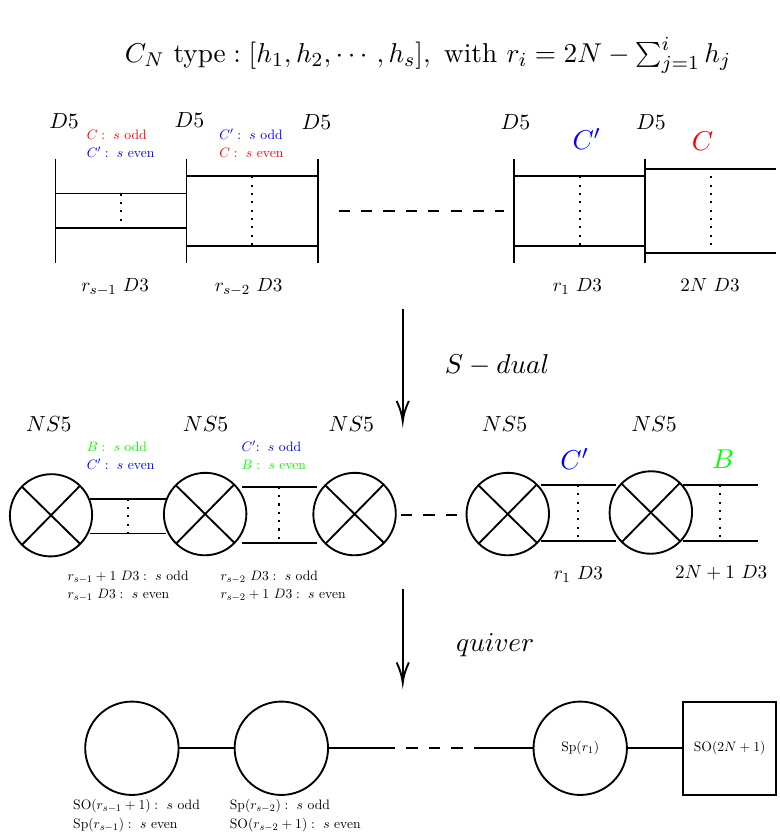
Figure 9 . Upper row: we construct a D 5 − D 3 brane system for a C type partition. There should be even number of D3 branes for C type or C 0 type O3 planes. For a general C type partition, the brane configuration would violate the rule for O3 planes, and we add one more D3 brane so that the number is consistent with the O plane type. Middle: we perform S duality on brane system in upper row, which turn a D5 brane to a NS5 brane, and D3 brane to a D3 brane. Bottom row: we read a quiver gauge theory from brane configuration of middle